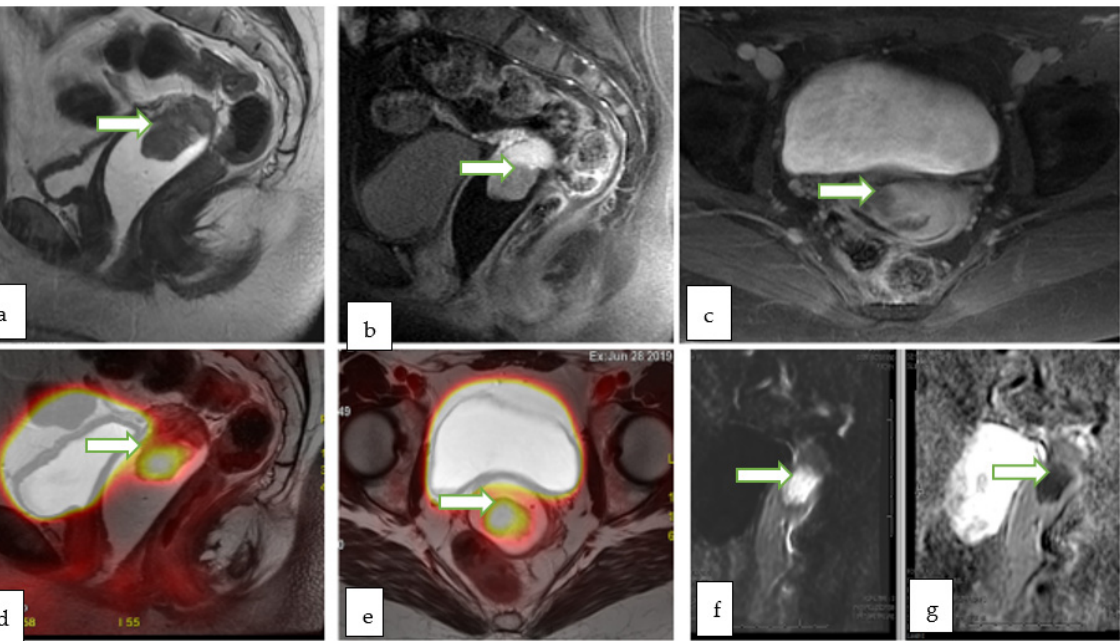
Figure 12. Sagittal T2W ( a ), sagittal post contrast fat saturated T1W ( b ) and axial post contrast fat saturated T1W ( c ) images through the pelvis of a 31 year old lady with incidentally discovered cervical mass during infertility workup, show an exophytic cervical mass arising from the anterior lip. The lesion appears bright in DWI ( f ) with low ADC ( g ) values consistent with diffusion restriction. Corresponding sagittal ( d ) and axial ( e ) color fused PET MRI images showed the FDG avid hypermetabolic cervical mass with maximum SUV of 13.4. There was no evidence of vaginal cuff involvement, parametrial extension or pelvic/inguinal lymphadenopathy. Biopsy of the cervical mass revealed invasive high-grade carcinoma with an adenocarcinoma component.